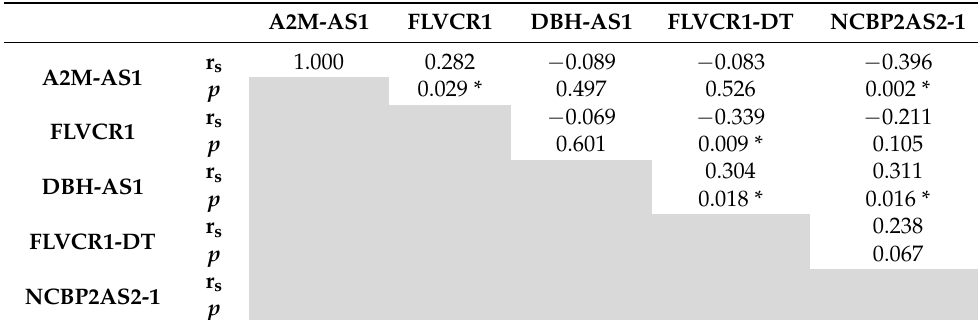
Table 5. Correlation between different parameters in group